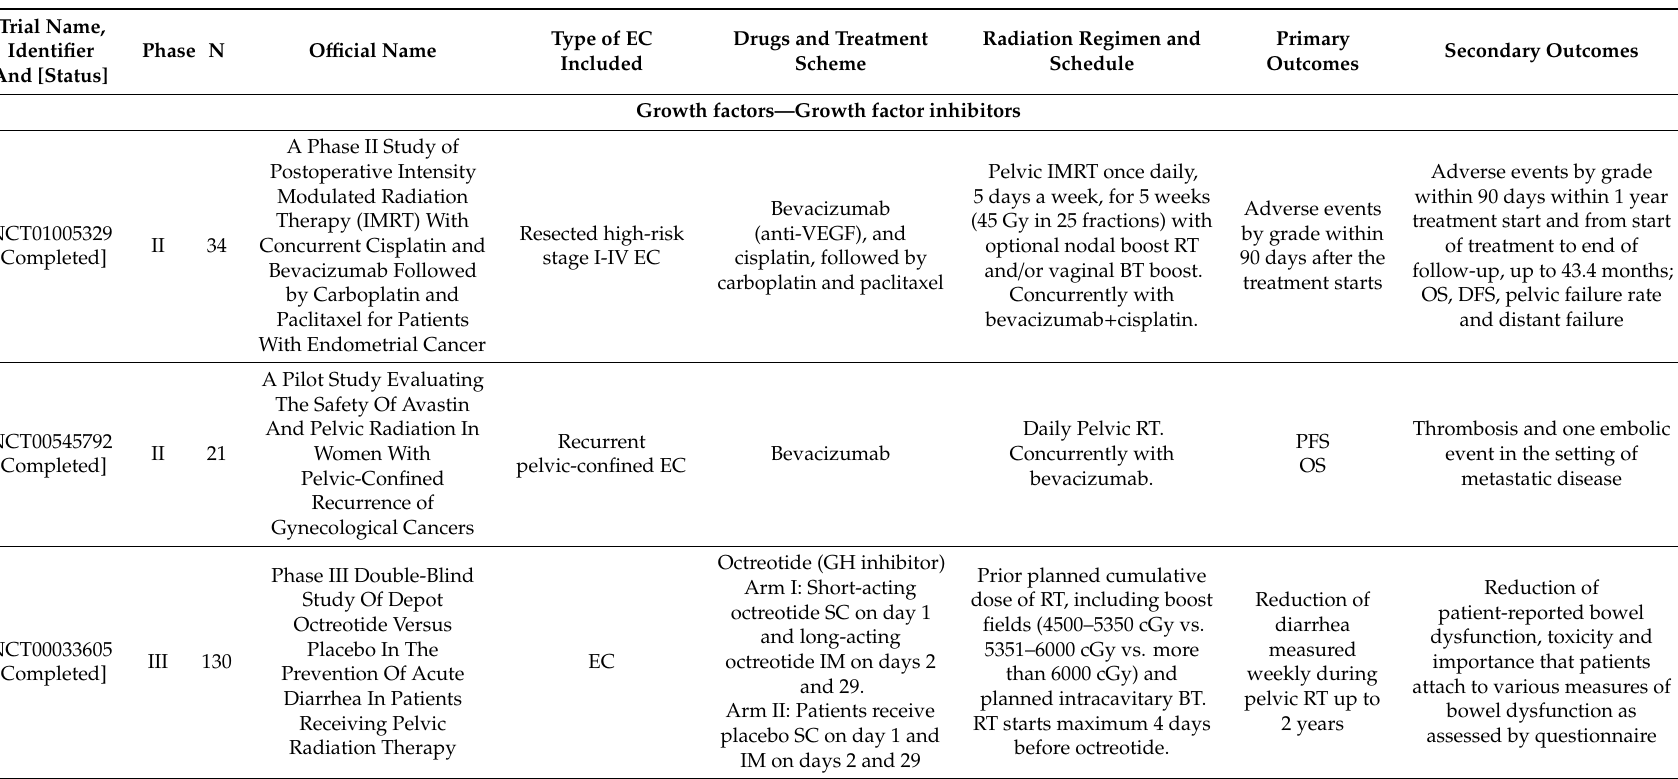
Table 1. Clinical Trials with Targeted Therapies with Radiosensitization